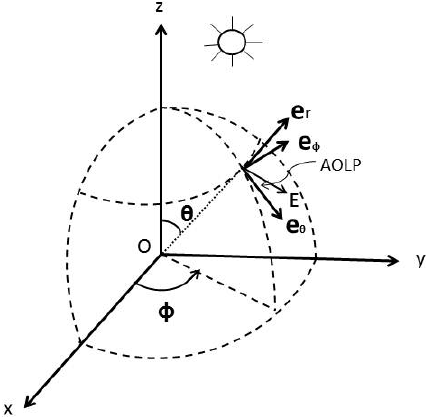
Fig. 1. Geometry of light’s reflection in the ocean–atmosphere sys-